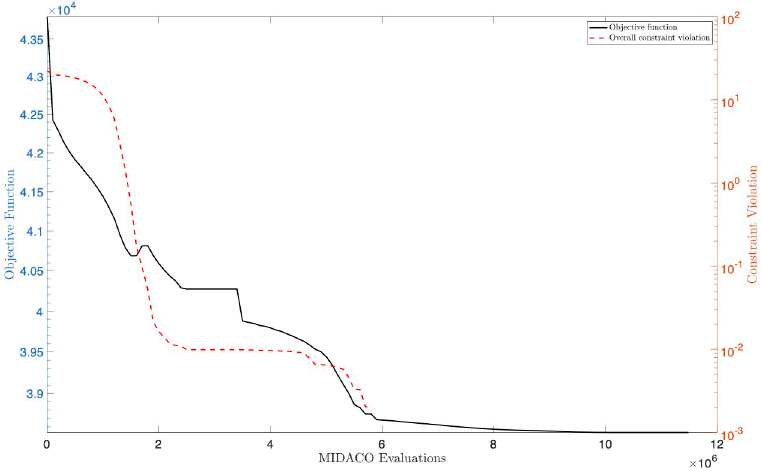
Fig 2. Objective function value and overall constraint violation for the solution found using MIDACO, plotted against the number of candidate solutions evaluated.